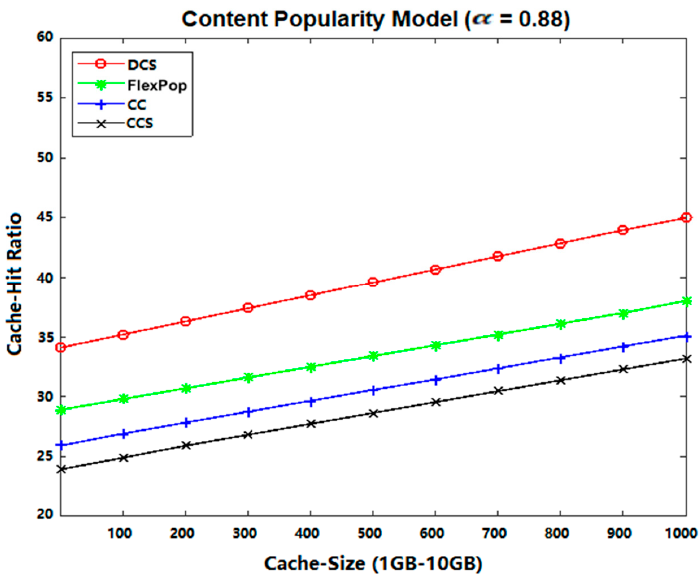
Figure 11. Cache Hit Ratio on Abilene Topology with UGC.